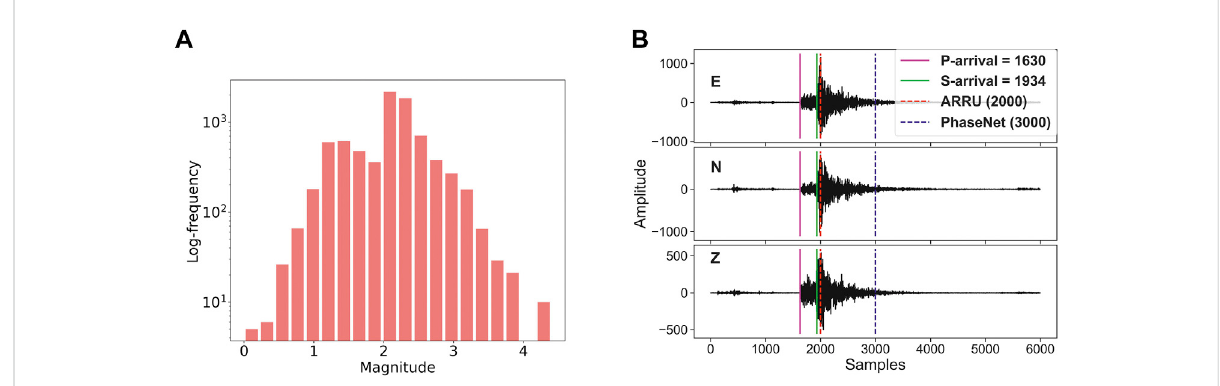
FIGURE 5 Magnitude distribution and seismic signal visualization of the used subset of the INSTANCE dataset (Michelini et al., 2021). (A) shows the frequencydistributionofthetestdatamagnitude,and (B) visualizesone3-componentseismicwaveformmarkedwithdifferenttimeintervals.Here,a 60-s seismic waveform is sampled at 100 Hz. The evaluated models use different lengths of the same seismic event, marked with different dashed lines.